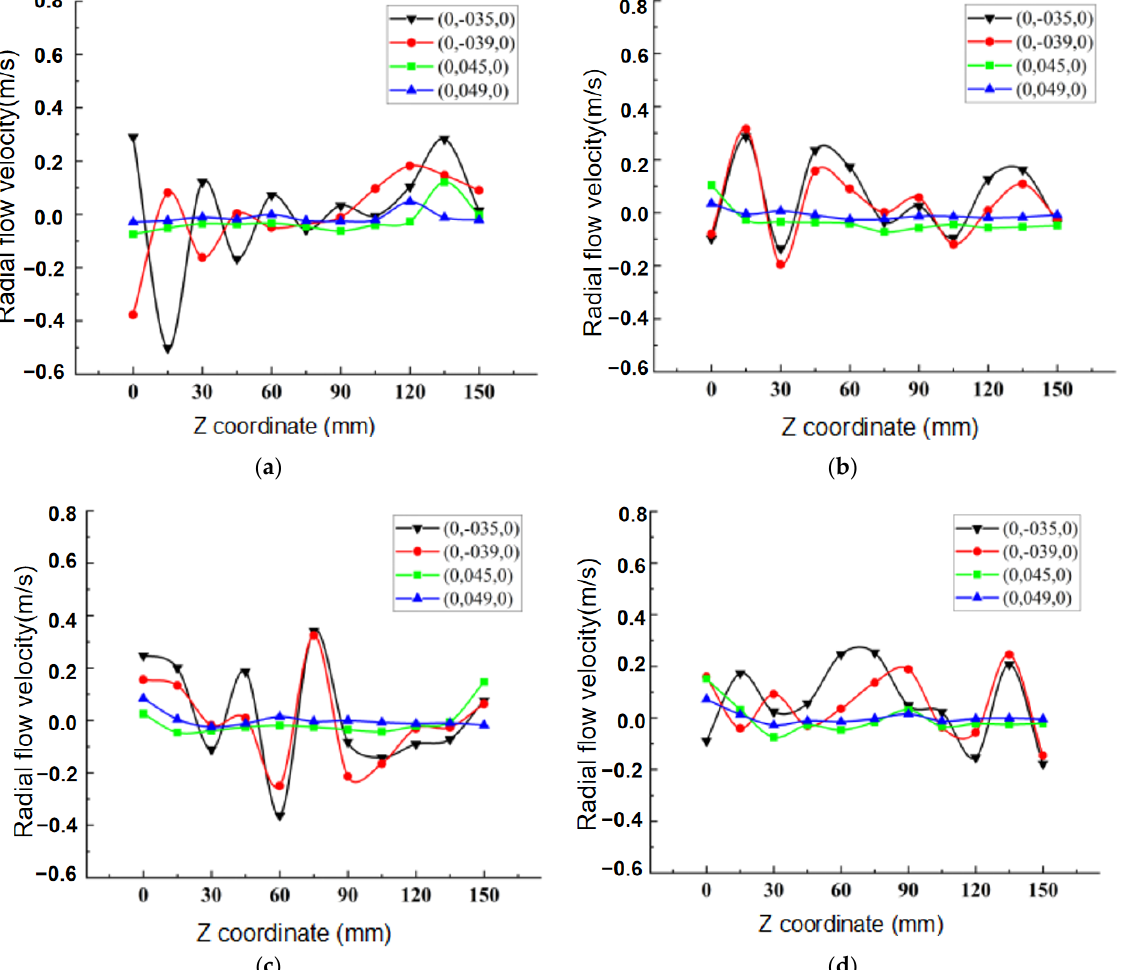
Figure 8. Variation curve of radial velocity of annular slit flow at the same measuring point along the flow. ( a ) Position 1; ( b ) position 2; ( c ) position 3; ( d ) position